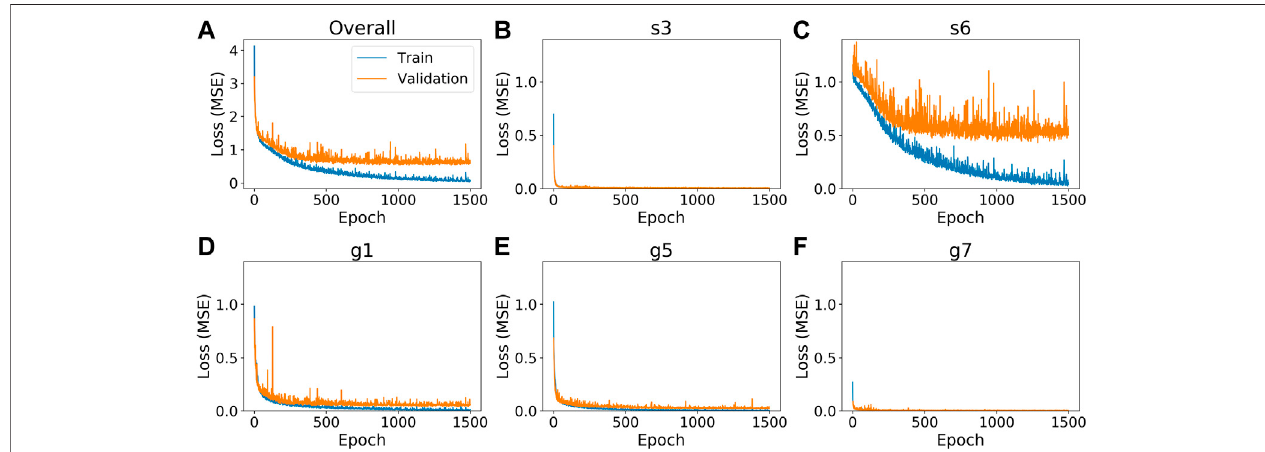
FIGURE3| TraininglossofthebestDNNA3model.Thebluelineisthelossfromthetrainingsetandtheorangelineisthelossfromthevalidationsset.The x -axisis the epoch number. The y -axis is the model loss (MSE). (A) overall training loss of best DNN A3 model. The overall loss is the sum of the loss of the fi ve permeability parameters (B – F) ; (B) training loss for the s3 permeability parameter; (C) training loss for the s6 permeability parameter; (D) training loss for the g1 permeability parameter; (E) training loss for the g5 permeability parameter; (F) training loss for the g5 permeability parameter.